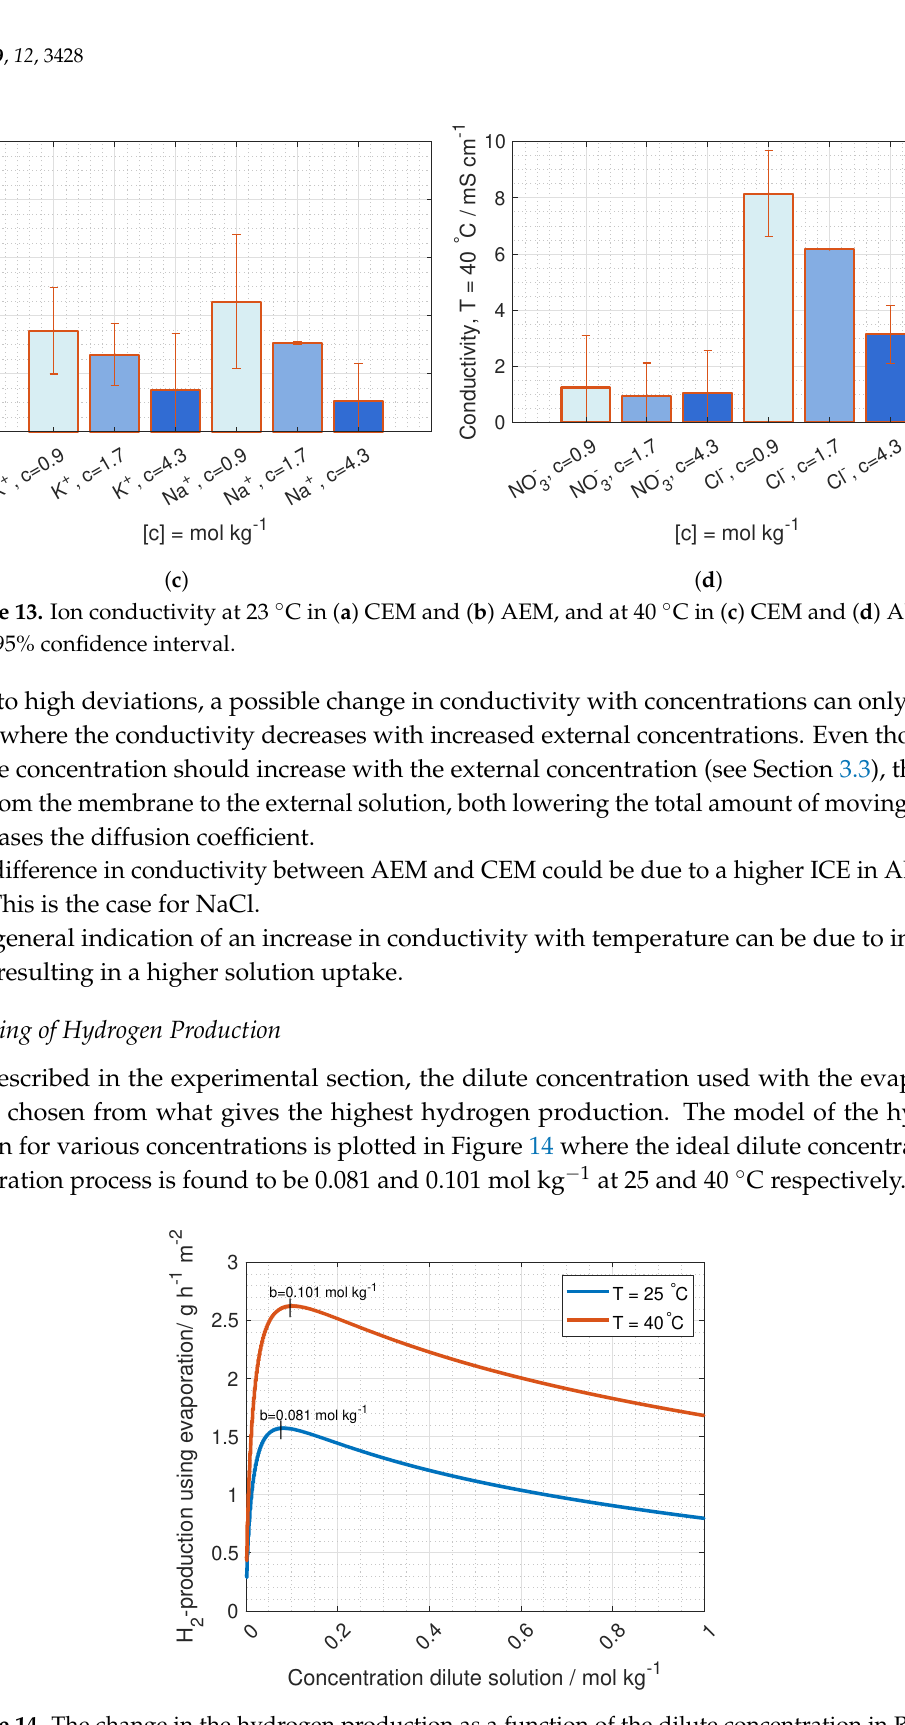
Figure 14. The change in the hydrogen production as a function of the dilute concentration in RED. The concentration of the concentrated inlet is set by the solubility limit at 25 and 40 ◦ C, 3.79 and 6.22 mol kg − 1